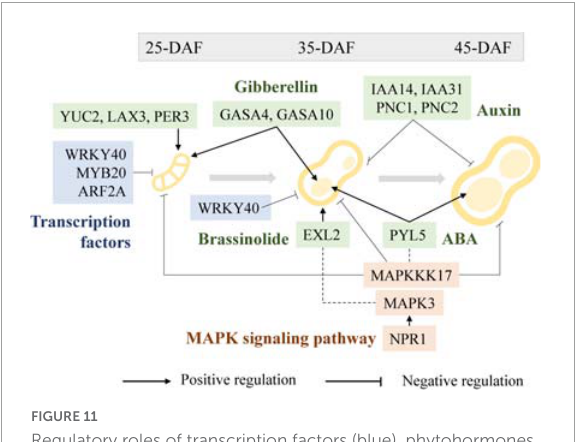
FIGURE11 Regulatory roles of transcription factors (blue), phytohormones (green), and MAPK signaling pathway (pink) in peanut pod development.